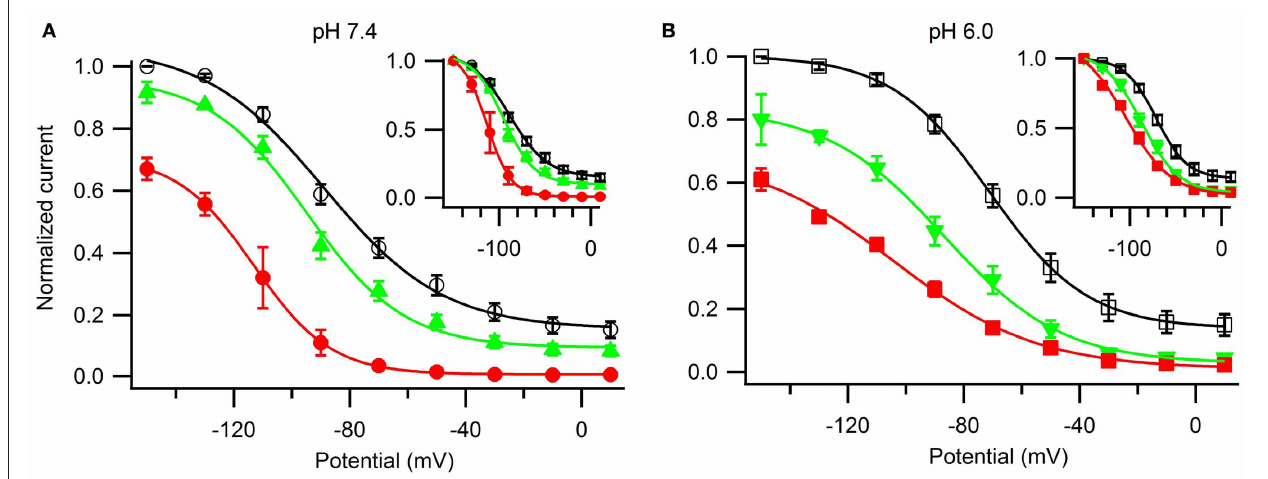
FIGURE 9 | The effects of ranolazine on steady-state slow inactivation and tonic block. Slow inactivation was induced with alternating 30s conditioning pulses to a range of voltages ( − 150mV through + 10mV in 10mV intervals) followed by a 20ms recovery period at − 130mV to allow recovery from fast inactivation, and a − 10mV test pulse to measure channel availability. Channels spent additional 30s at holding potential − 130mV between the sweeps. Matched pair experiments before and after ranolazine perfusion were performed to assess tonic inhibition by the drug at − 150mV (pH 7.4: 10 μ M 8 ± 3%, n = 3, p = 0 . 001; 100 μ M 33 ± 4%,